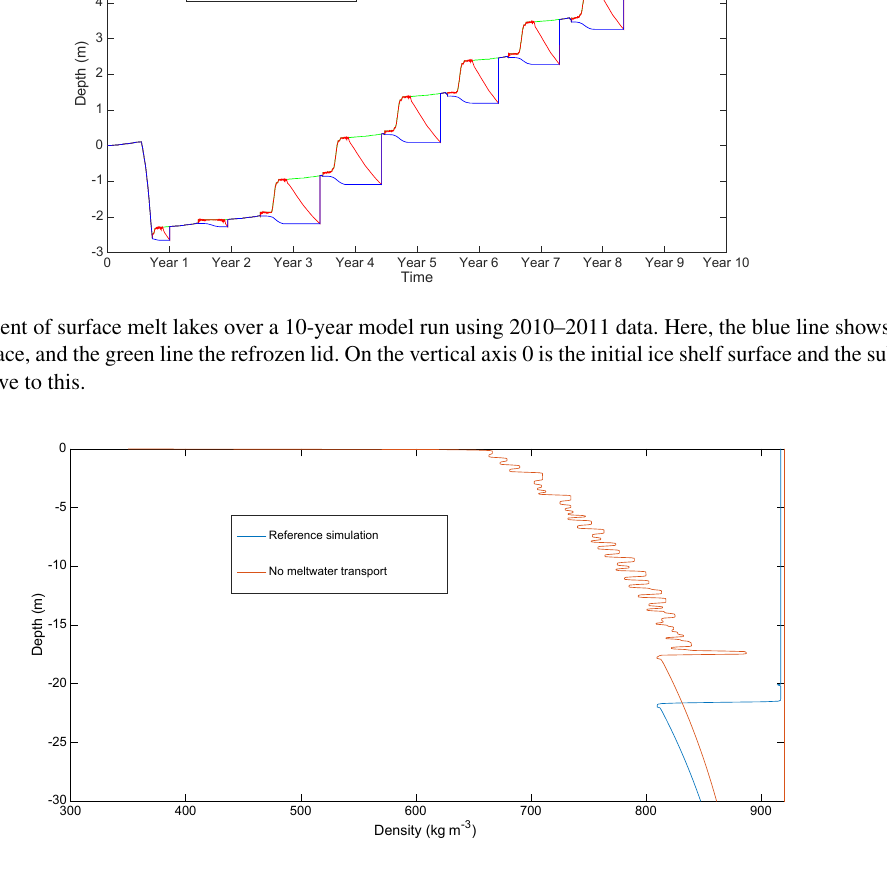
Figure 3. The density changes at the end of the spin-up period (after 5 years) for the reference case (blue) and the case in which all meltwater subsequent to ice lens formation leaves the model domain upon formation (red). Here 0 on the vertical axis is the ice shelf surface. Low densities at the surface are due to new